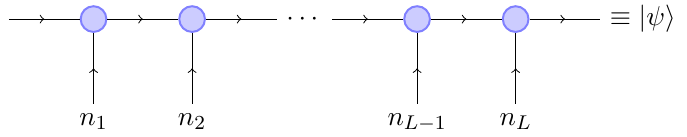
Figure 1: MPS representation of an arbitrary U ( 1 ) -invariant quantum state | ψ 〉 . The circles represent site tensors with physical degrees of freedom labeled by n correspond to the indices of the site tensors T n i ≡ T n i α